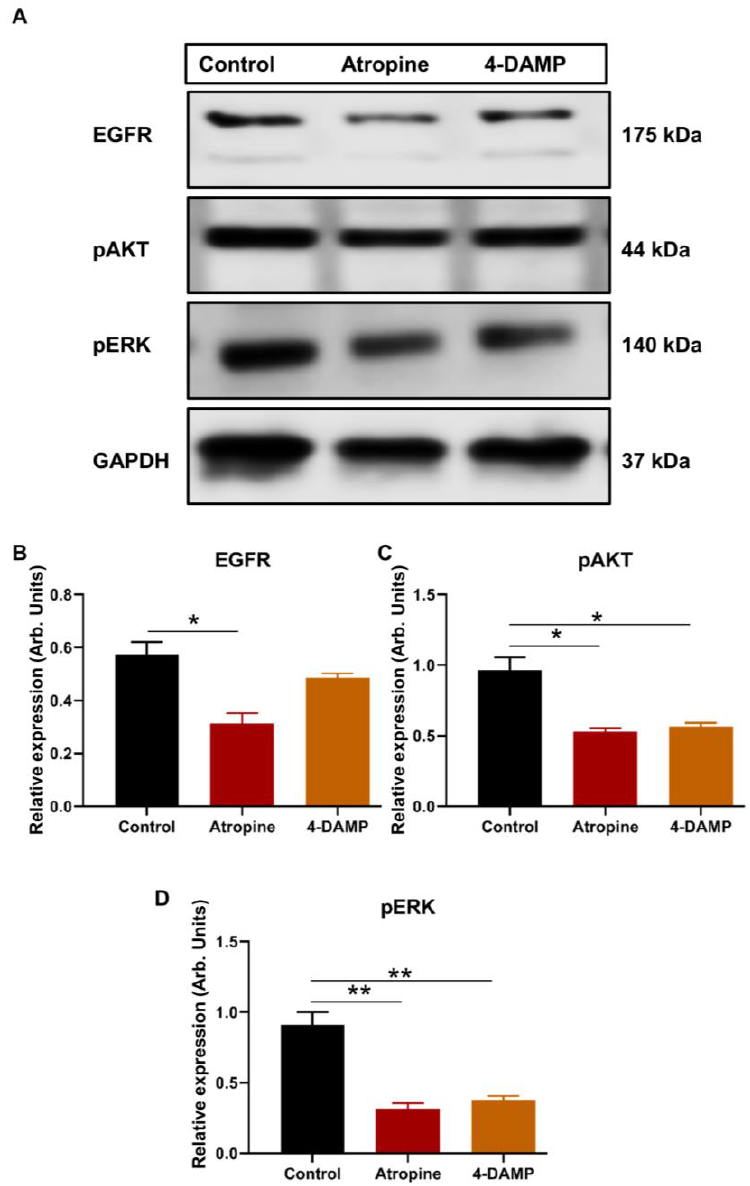
Figure 3. Effect of atropine and 4-DAMP on the expression of protein kinases in CT-26 cells. Western blot bands for EGFR, pAKT, and pSTAT3 expression in CT-26 cells treated with atropine and 4-DAMP ( A ). Bar graphs displaying the mean intensity of EGFR ( B ), pAKT ( C ), and pERK ( D ) expression in CT-26 cells treated with 4-DAMP and atropine. Data presented as mean ± SEM. Two-way ANOVA, * p < 0.05, ** p < 0.01.